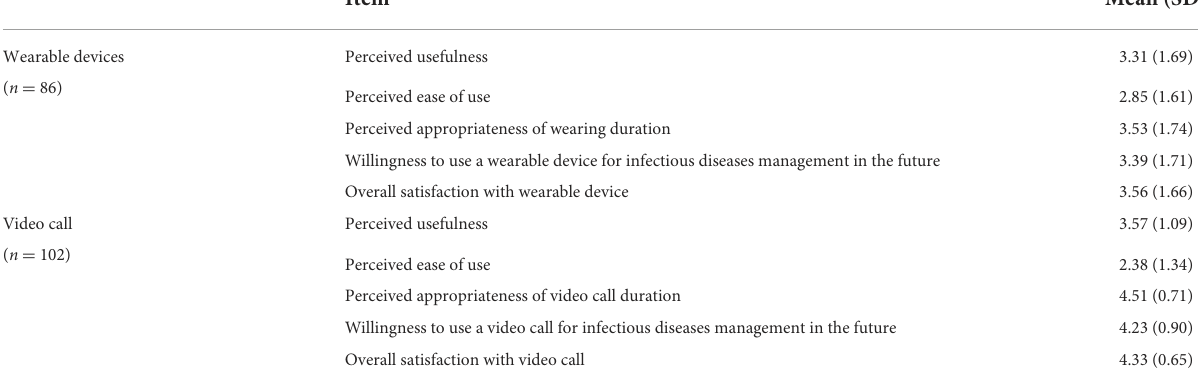
TABLE 4 Results of the online survey on satisfactory level of overall